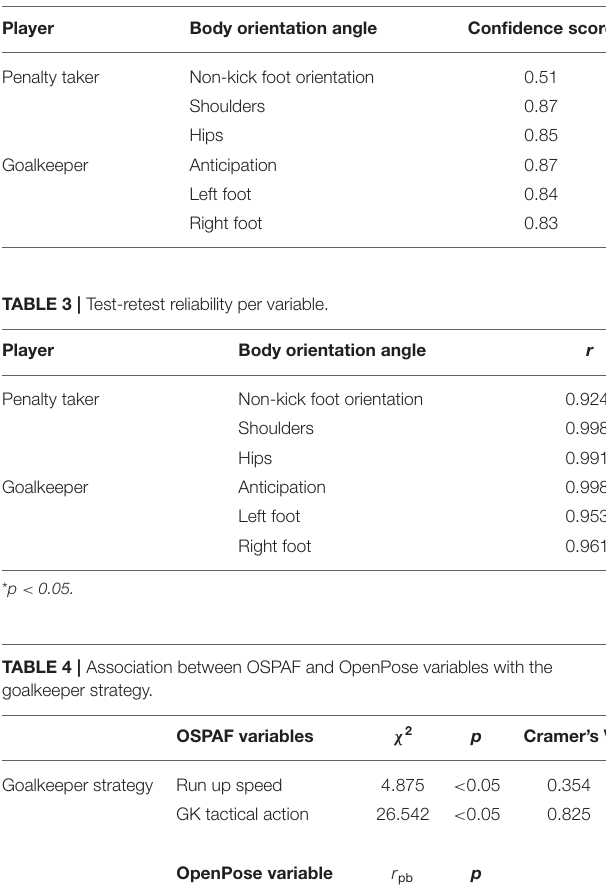
TABLE 2 | OpenPose confidence score per variable.